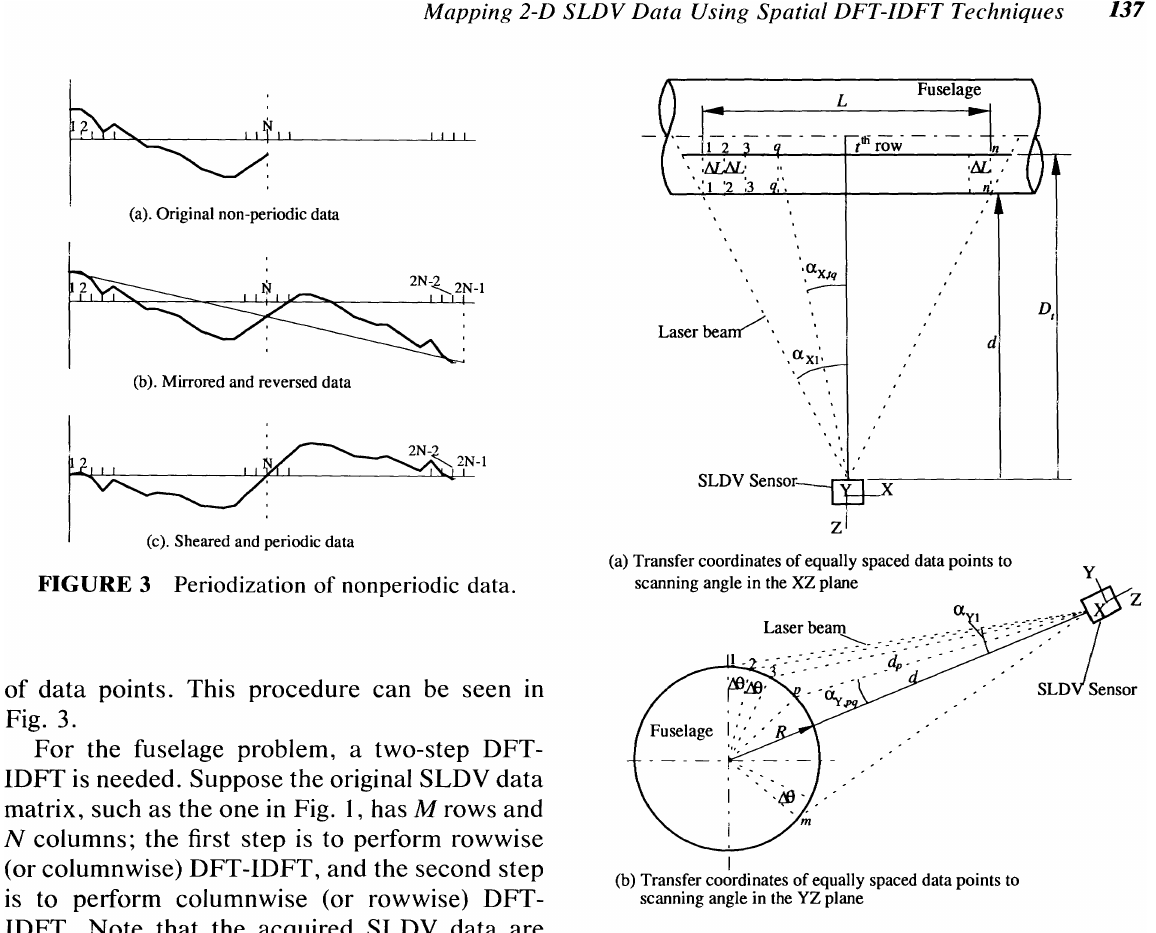
FIGURE 4 Transfer coordinates of equally spaced data points to scanning